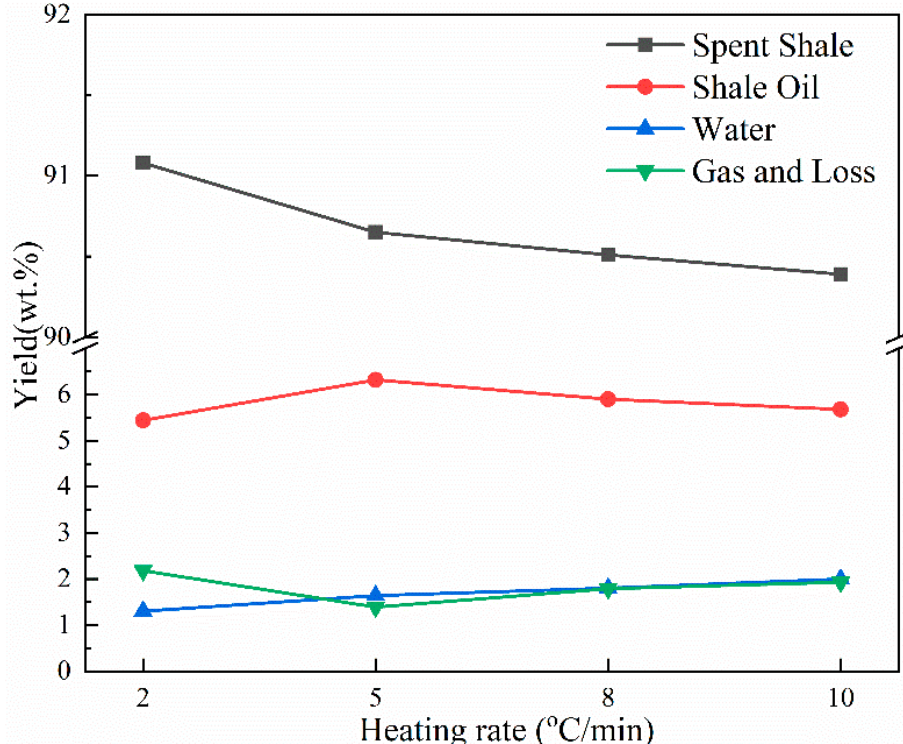
Figure 5. Yields of pyrolysis products of Jimsar oil shale at different heating rates.